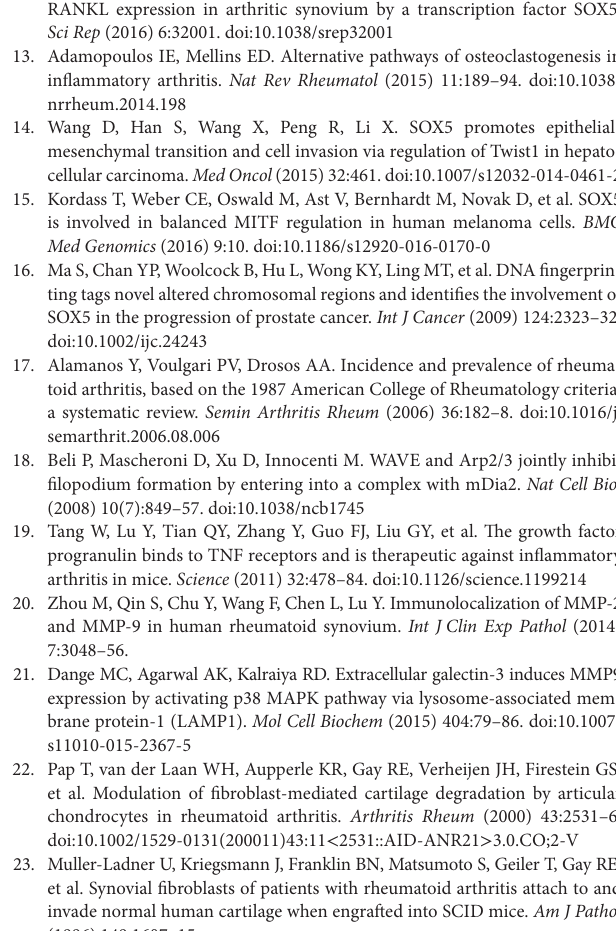
FigUre s1 | Knockdown MMP-9 inhibits RA FLS migration and invasion. Following transfected with LV-shSOX5 or Mock for 24h, FLS ( n = 3) subjected to transwell (above), and transwell chamber invasion assay after 24 h (below). Graphs show the quantitation data derived from the left figure. Data are each representative of three independent experiments. FigUre s2 | Recombinant MMP-9 rescues the inhibitory effect of LV-shSOX5#2 on FLS migration and invasion. Following knockdown SOX5 with LV-shSOX5#2 treated in FLS for 96 h, FLS with or without recombinant MMP-9 (50 ng/mL) were subjected to transwell (a) , and transwell chamber invasion assay (c) after 24 h. MH7A cell was used in wound healing test (B) . Graphs show the quantitation data. Data are each representative of three independent experiments. FigUre s3 | DNA sequence of 2-kb MMP-9 promoter. Four putative SOX5-binding sites have been identified in the 2-kb promoter of MMP-9 by an online software (http://jaspar.genereg.net/). One putative binding site located at − 1154 to − 1146 with the highest predicted score was marked with red. The deleted putative SOX5 binding site from − 1300 to − 900 of the proximal promoter was marked with italic. FigUre s4 | Original images of Figures 1a , 2c . FigUre s5 | Original images of Figure 2D . FigUre s6 | Original images of Figure 5a-1 . FigUre s7 | Original images of Figure 5a-2